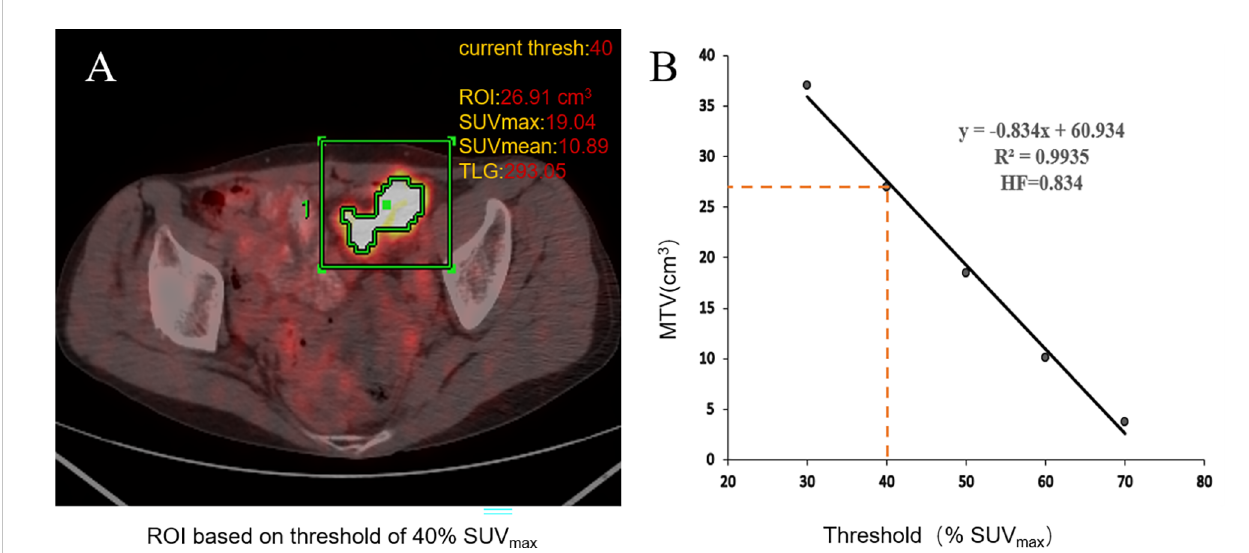
FIGURE 2 Work fl ow of 18 F-FDG PET/CT metabolic parameter measurements. When using the percent threshold of 40%, SUV max was 19.04, the volume of ROI was 26.91 cm 3 , SUV mean was 10.98, and TLG was 293.05. HI = SUV max /SUV mean = 1.75 (A) . The HF is the absolute value of the linear regression slope calculated by the least square method from the different threshold of the ROI; the threshold of tumor volumes ranged from 30% to 70% of SUV max (B)